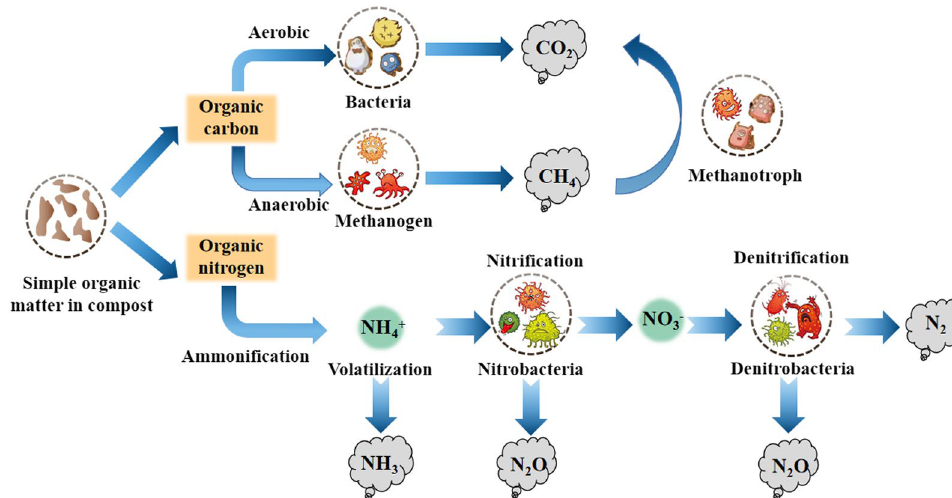
Fig. 4 Flow chart of greenhouse gas emissions during composting